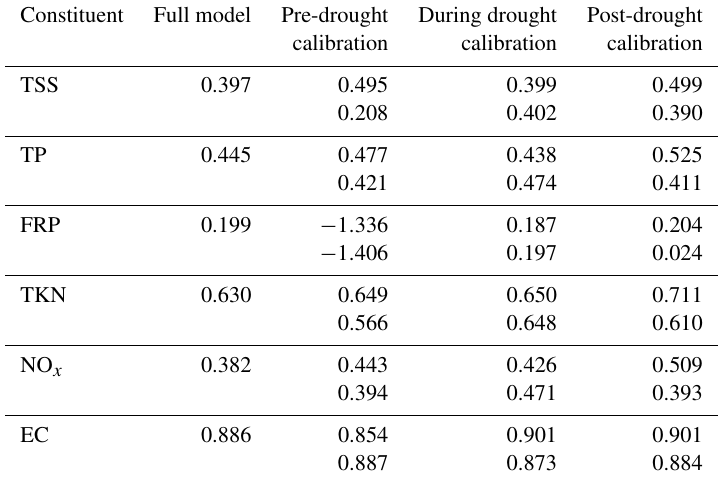
Table 6. Comparison of model performance (NSE values) of the full model and the three models that were calibrated using the pre-drought is shown in the top row and the validation performance (i.e., over the periods that were not used for calibration) is shown in the bottom